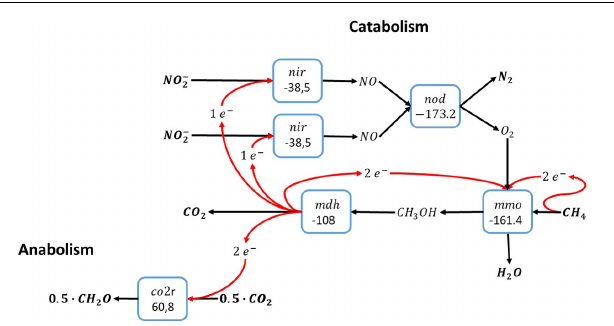
FIGURE 2 | Methane oxidation with nitrite as electron acceptor via anaerobic production of molecular oxygen (Raghoebarsing et al., 2006). The individual blocks represent enzymatic steps ( nod , nitric oxide dismutase; nir , nitrite reductase; mmo , methane monooxygenase; mdh , methanol dehydrogenase co2r , CO 2 fixation); and the corresponding Gibbs free energy change ( (cid:52) G 0 (cid:48) ) of the reactions corrected for a pH of